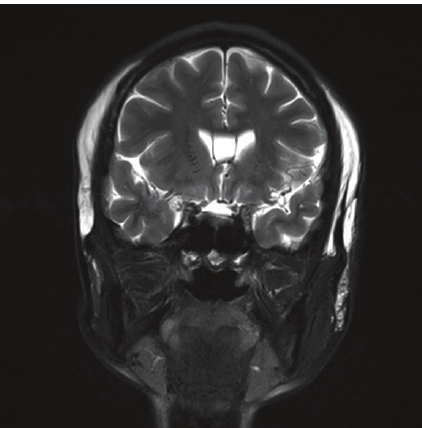
Figure 2: Sagittal image showing PAAG migration into both the upper and lower eyelids.